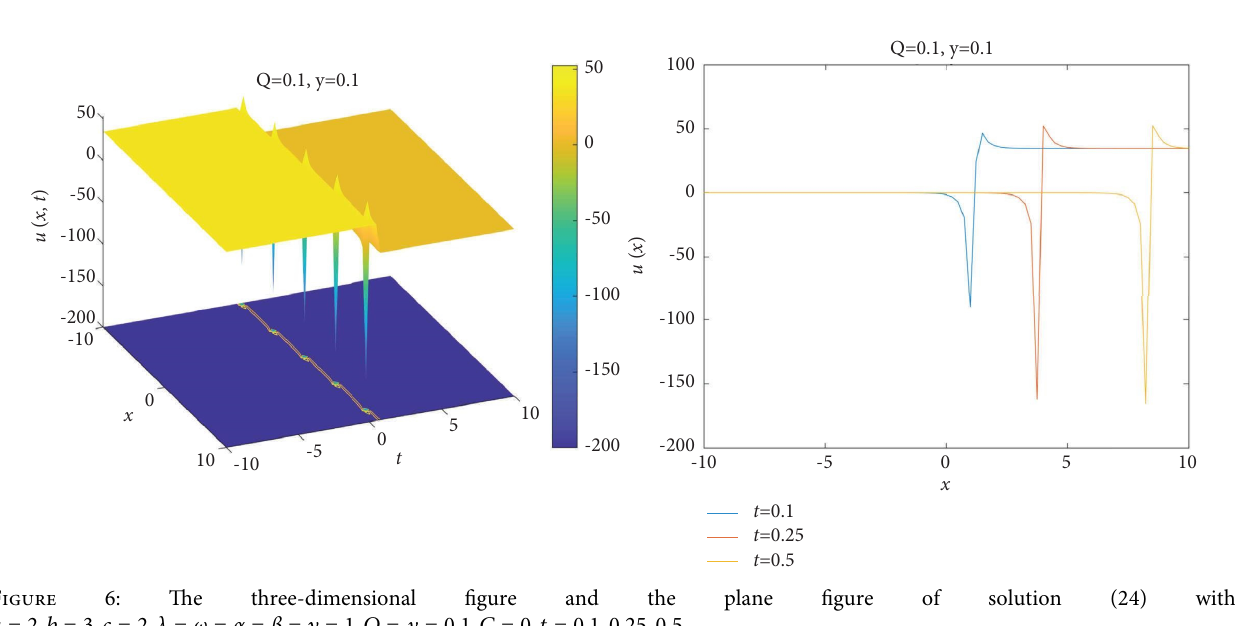
5: Te three-dimensional fgure and the plane fgure of the solution (8) with a � 2 ,b � 3 , c � 2 , λ � ω � α � β � c � 1 ,Q � y � 0 . 1 , C � 0 , t � 0 . 05 , 0 . 15 , 0 . 25.